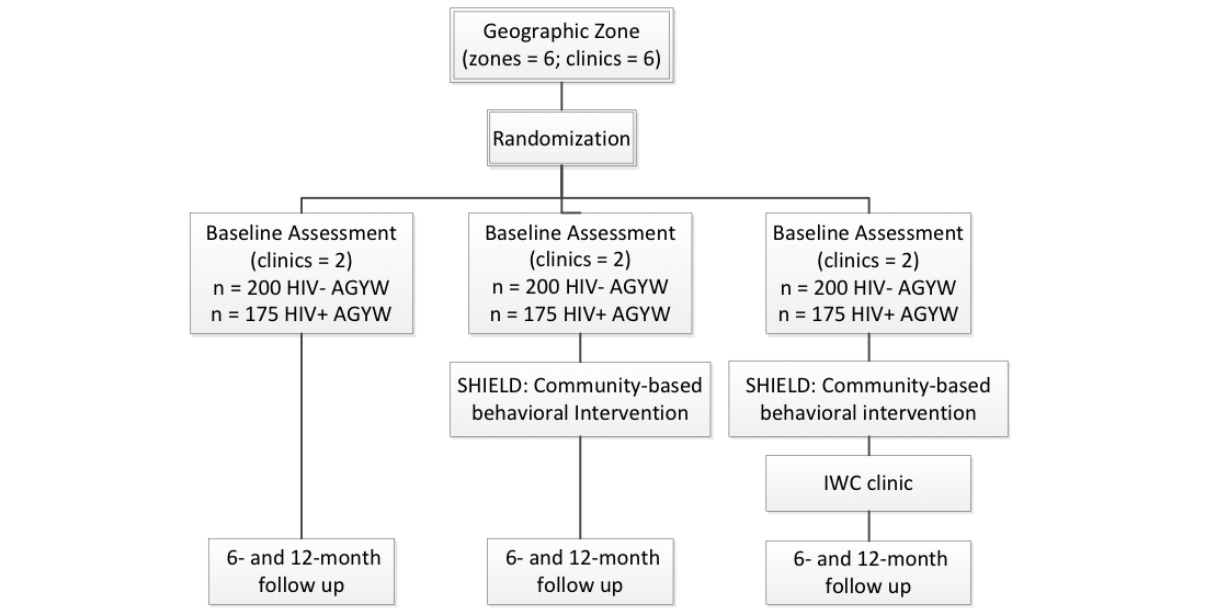
Figure 2. Experimental design and sample sizes. AGYW: adolescent girls and young women; SHIELD: Support for HIV Integrated Education, Linkages to Care, and Destigmatization; IWC: integrated wellness